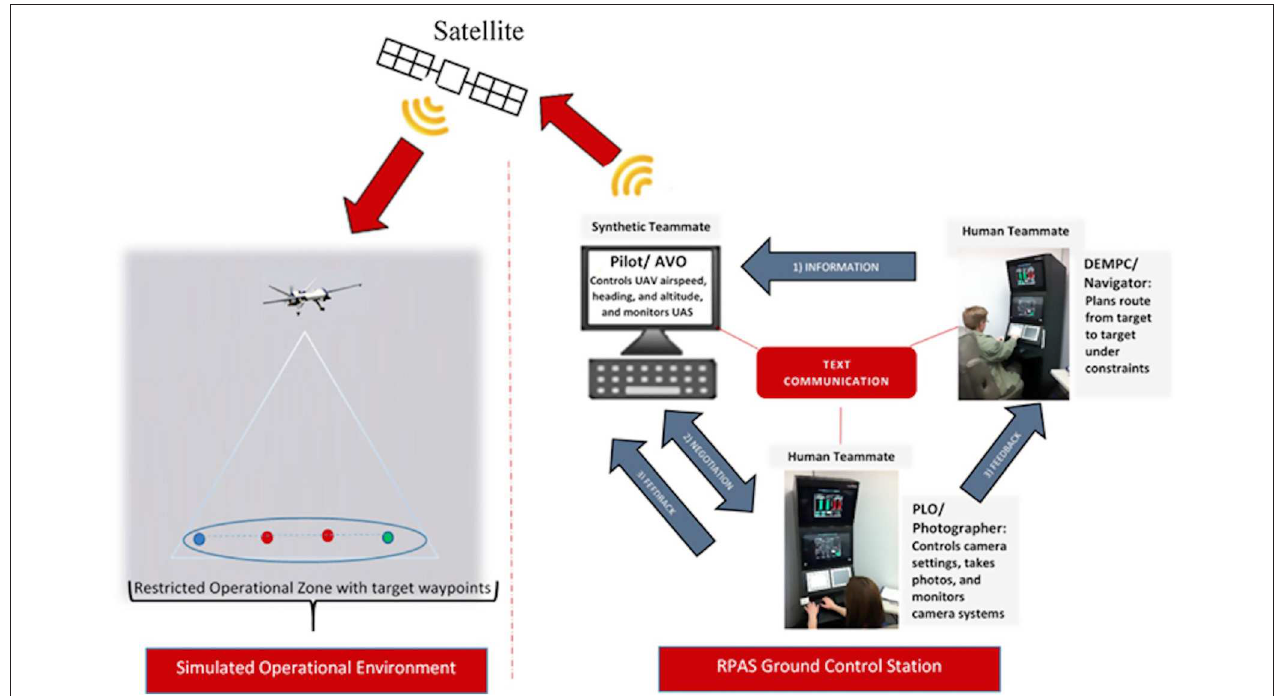
FIGURE 1 | Simulated RPAS task environment for each role, and task coordination (information-negotiation-feedback). The dashed line separates ground control station and simulated operational environment (from Demir et al., 2017; reprinted with permission).